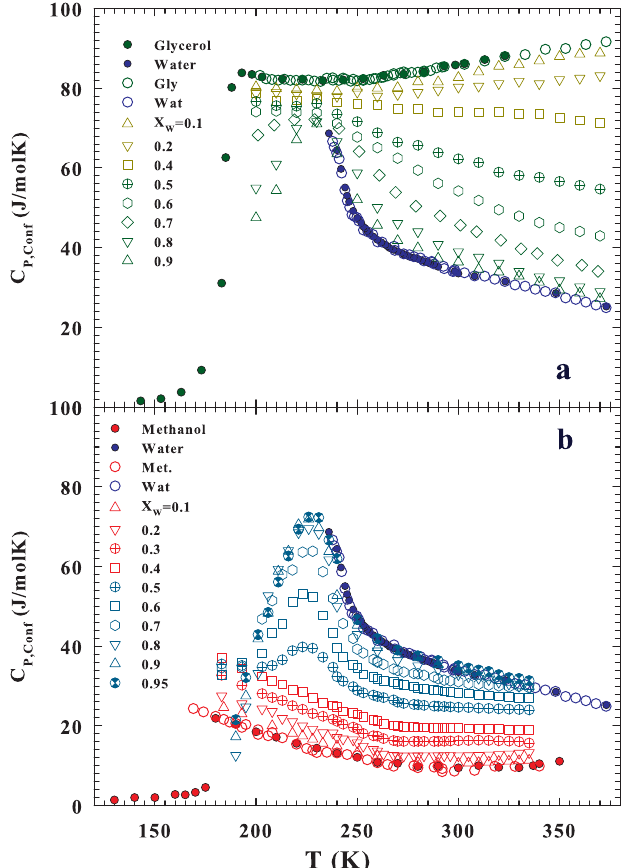
Figure 8. The configurational specific C P , conf ( a ) evaluated according to the Adam–Gibbs model for the solutions with water and glycerol at their different water molar fractions is illustrated. The bottom side ( b ), instead, shows the total specific heat of the water–methanol system, including their solution data and the same quantities evaluated for the water–methanol system. Both ∆ C P and C P , conf from pure glycerol, methanol, and water are also